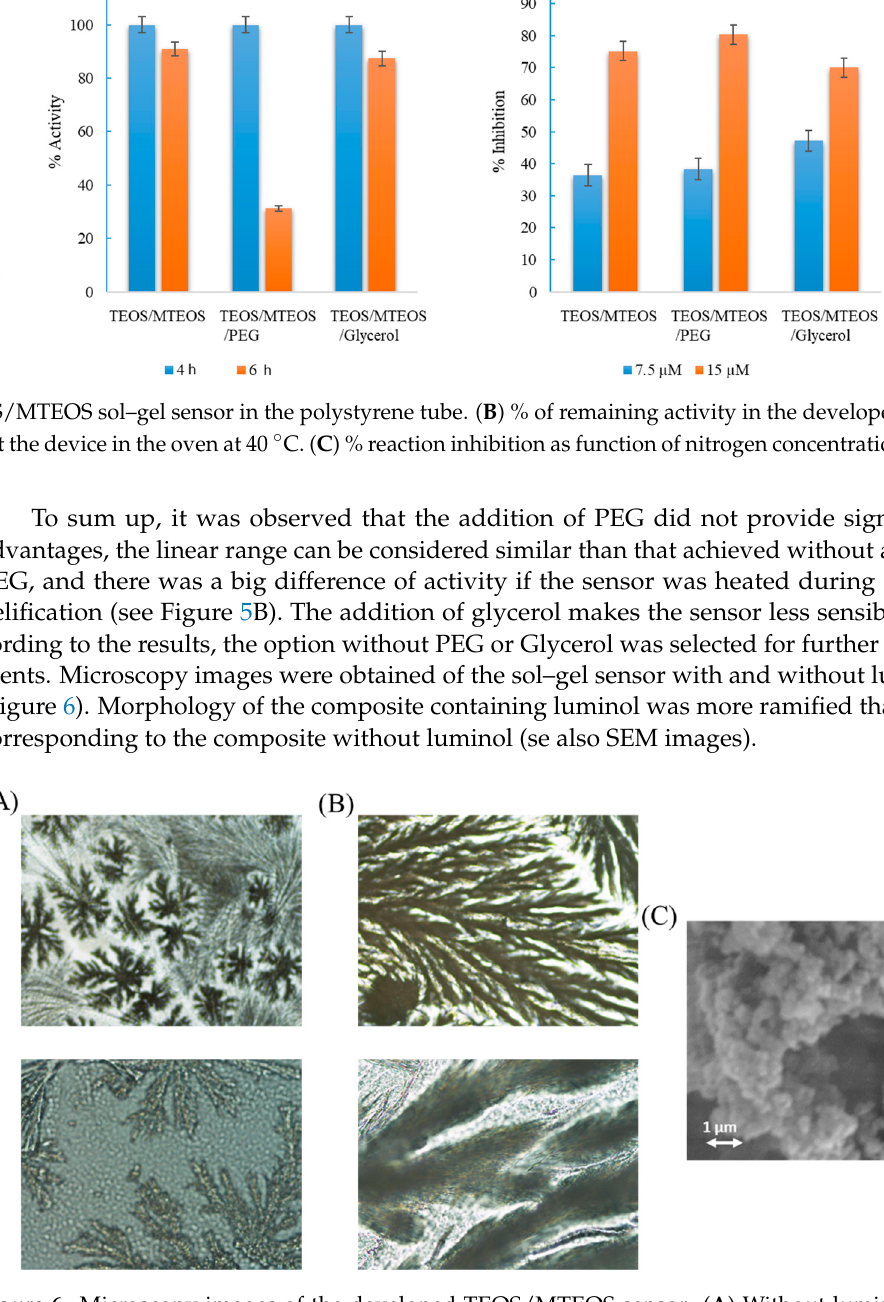
Figure 6. Microscopy images of the developed TEOS/MTEOS sensor. ( A ) Without luminol and ( B ) with luminol (10× and 50×). ( C ) SEM micrographs of